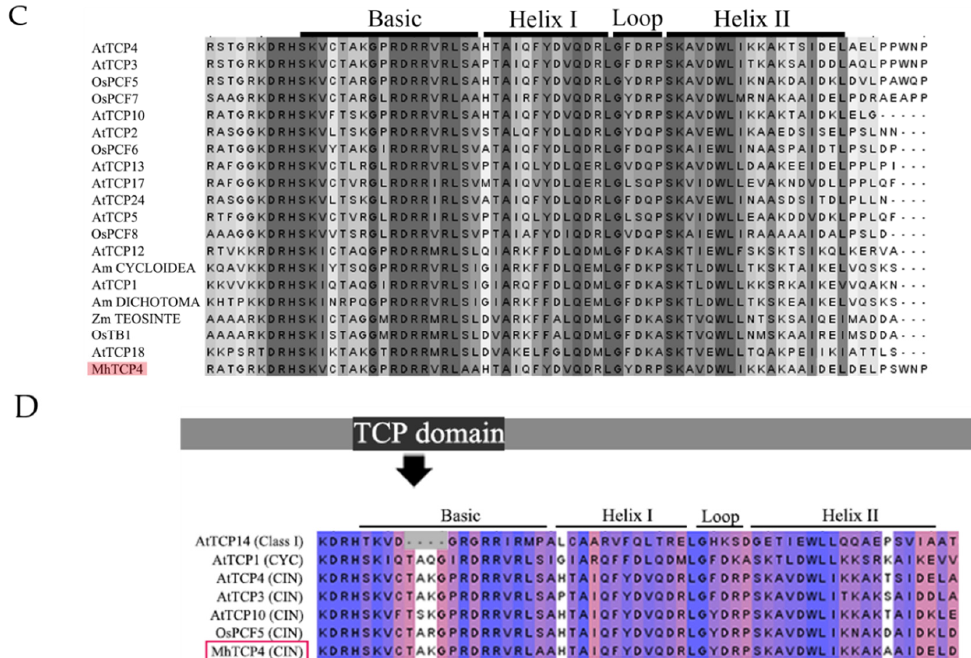
Figure 3. Sequence analysis and phylogenetic analysis of MhTCP4 protein. ( A ) The CDS and amino acid sequence of MhTCP4, and its three-dimensional structural model of protein with conserved domain. Inside the red box is the bHLH domain. ( B ) Phylogenetic analysis of MhTCP4 and its orthologous genes. The tree was constructed by neighbor-joining method. Branch numbers represent percentage of bootstrap values in 1000 sampling replicates and scale indicates branch lengths. ( C ) Analysis of conservative amino acid sequences of MhTCP4 and its orthologous proteins. A total of 20 proteins were Blast, based on UniProtKB/Swiss-Prot database. The species, gene names, and GeneBank accession numbers are as follows: Arabidopsis thaliana (AtTCP1, Q9FYG7.1), Arabidopsis thaliana (AtTCP2, Q93V43.1), Arabidopsis thaliana (AtTCP3, Q9MAH8.1), Arabidopsis thaliana (AtTCP4, Q8LPR5.1), Arabidopsis thaliana (AtTCP5, Q9FME3.1), Arabidopsis thaliana (AtTCP10, O82277.1), Arabidopsis thaliana (AtTCP12, A0AQW4.1), Arabidopsis thaliana (AtTCP13, Q9S7W5.1), Arabidopsis thaliana (AtTCP17, Q9LEZ9.1), Arabidopsis thaliana (AtTCP18, A1YKT1.1), Arabidopsis thaliana (AtTCP24, Q9C758.1), Oryza sativa Indica Group (OsPCF5, A2WM14.1), Oryza sativa Indica Group (OsPCF7,